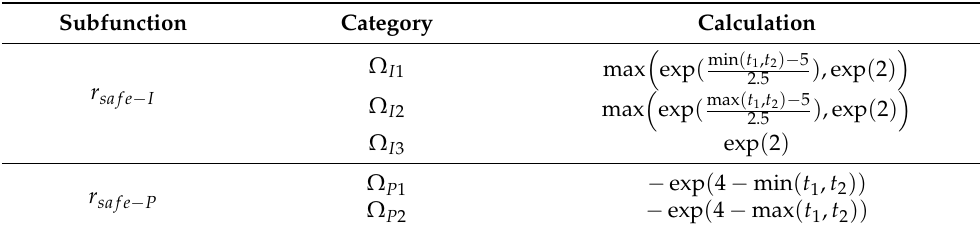
Figure 3. The driving hazard diagram. Table 4. The security-based reward